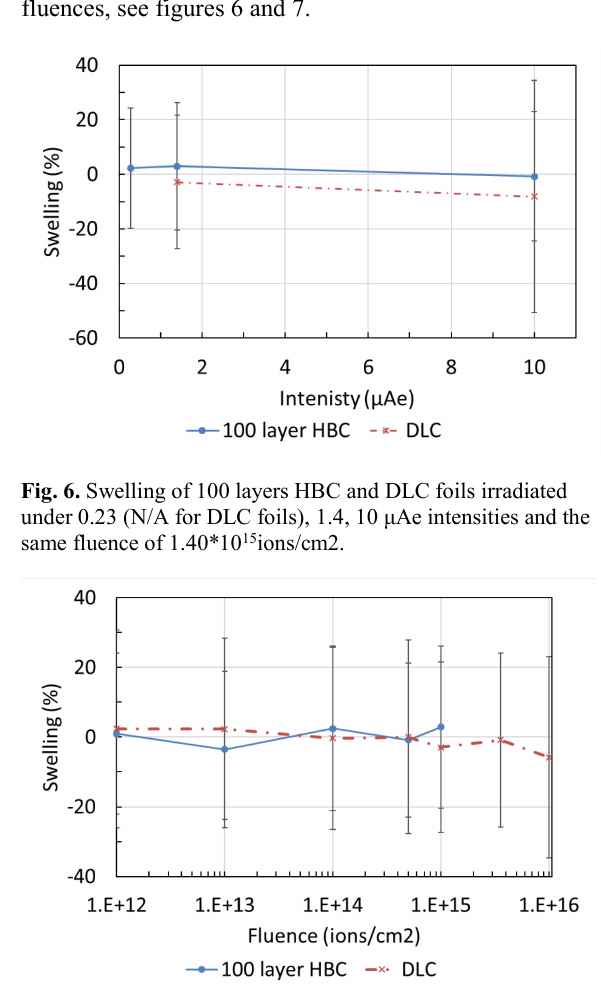
Fig. 7. Swelling of 100 layers HBC foils irradiated under 1.4 μAe intensity and the increasing